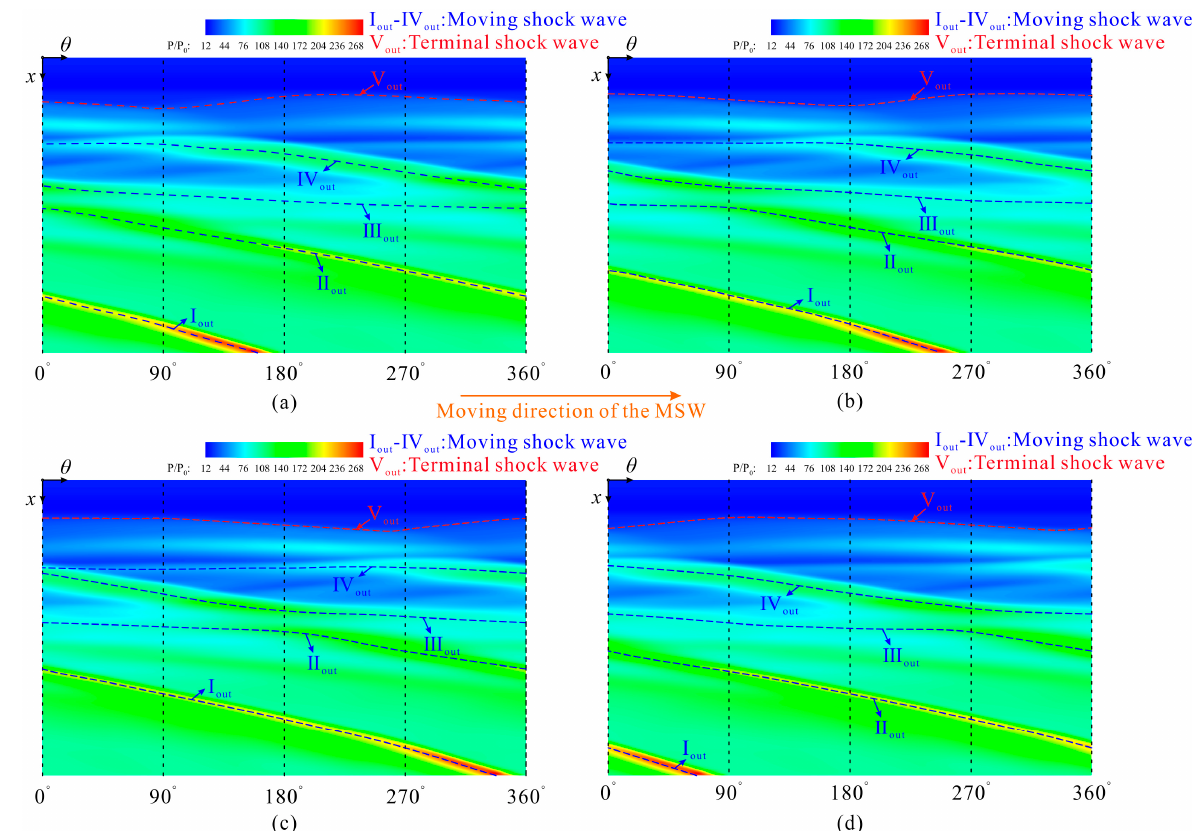
Figure 16. Pressure contours on the outer wall at different moments in one period. ( a ) t = n T . ( b ) t = (n + 1/4) T . ( c ) t = (n + 2/4) T . ( d ) t = (n + 3/4) T .